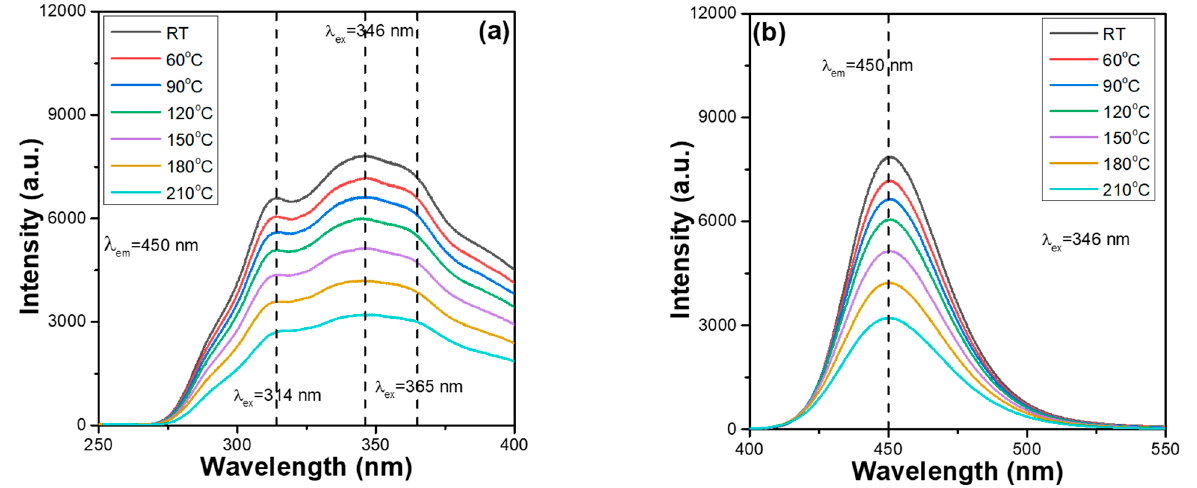
Figure 4. Temperature-dependent ( a ) PLE and ( b ) PL spectra of CaMgSi 2 O 6 :0.025Eu 2+ phosphor.